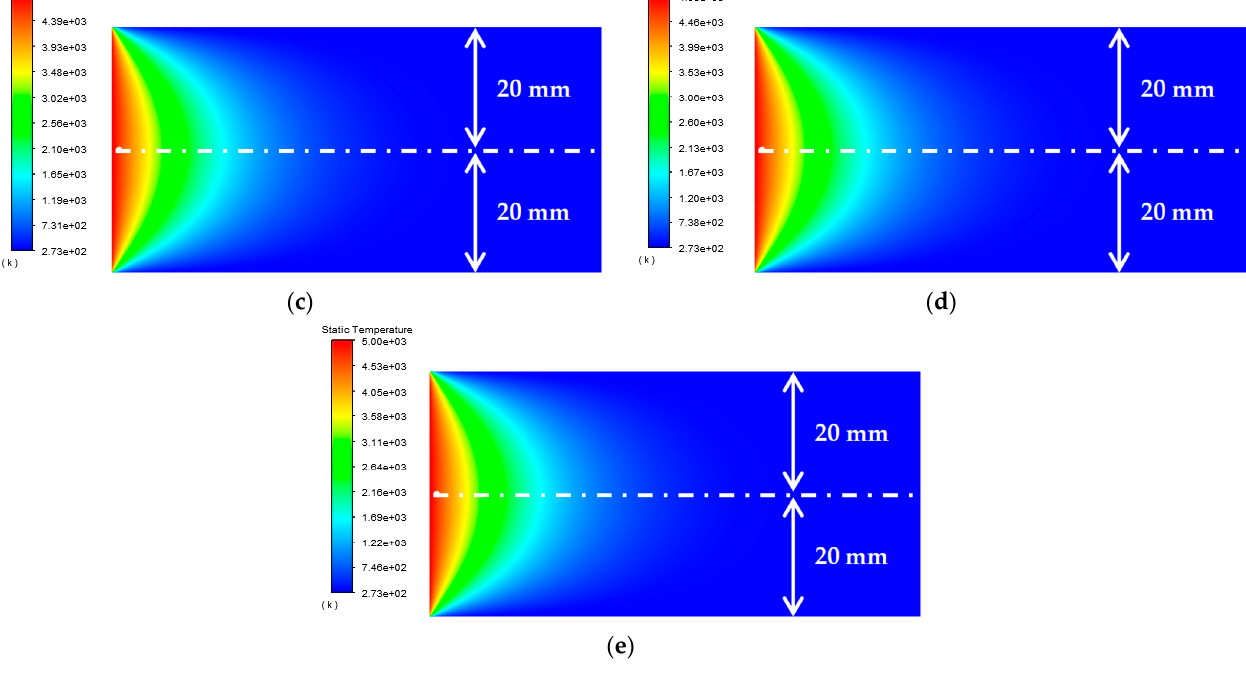
Figure 10. Surface temperature distribution diagram of platinum rhodium bushing: ( a ) ka = 1.1; ( b ) ka = 1.1; ( c ) ka = 1.1; ( d ) ka = 1.1; ( e ) ka = 1.1.